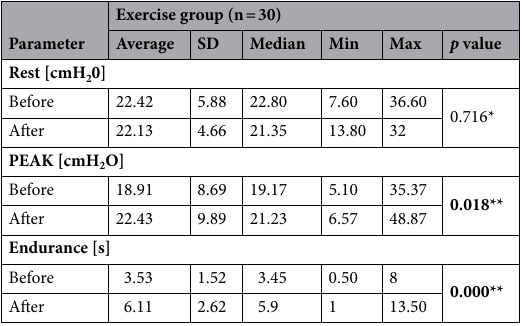
Table 2. Results of the resting pressure, peak pressure and endurance of the PFM using the perineometer in the exercise group. Values statistically significant are in bold. *Anova with repeated measures with Fisher post- hoc test. **Wilcoxon test.